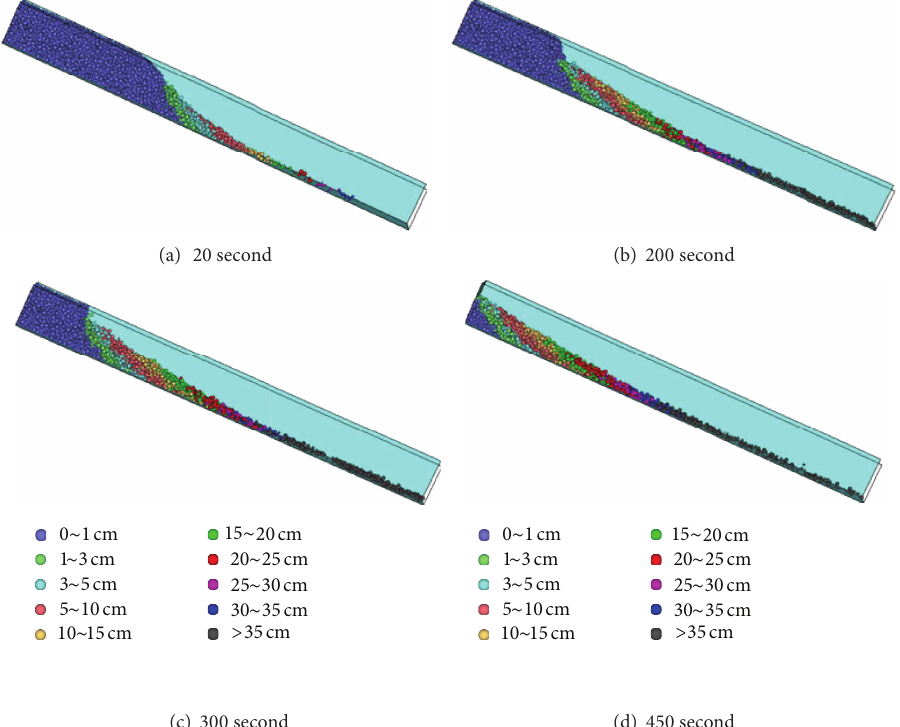
Figure 11: The deformation field of debris